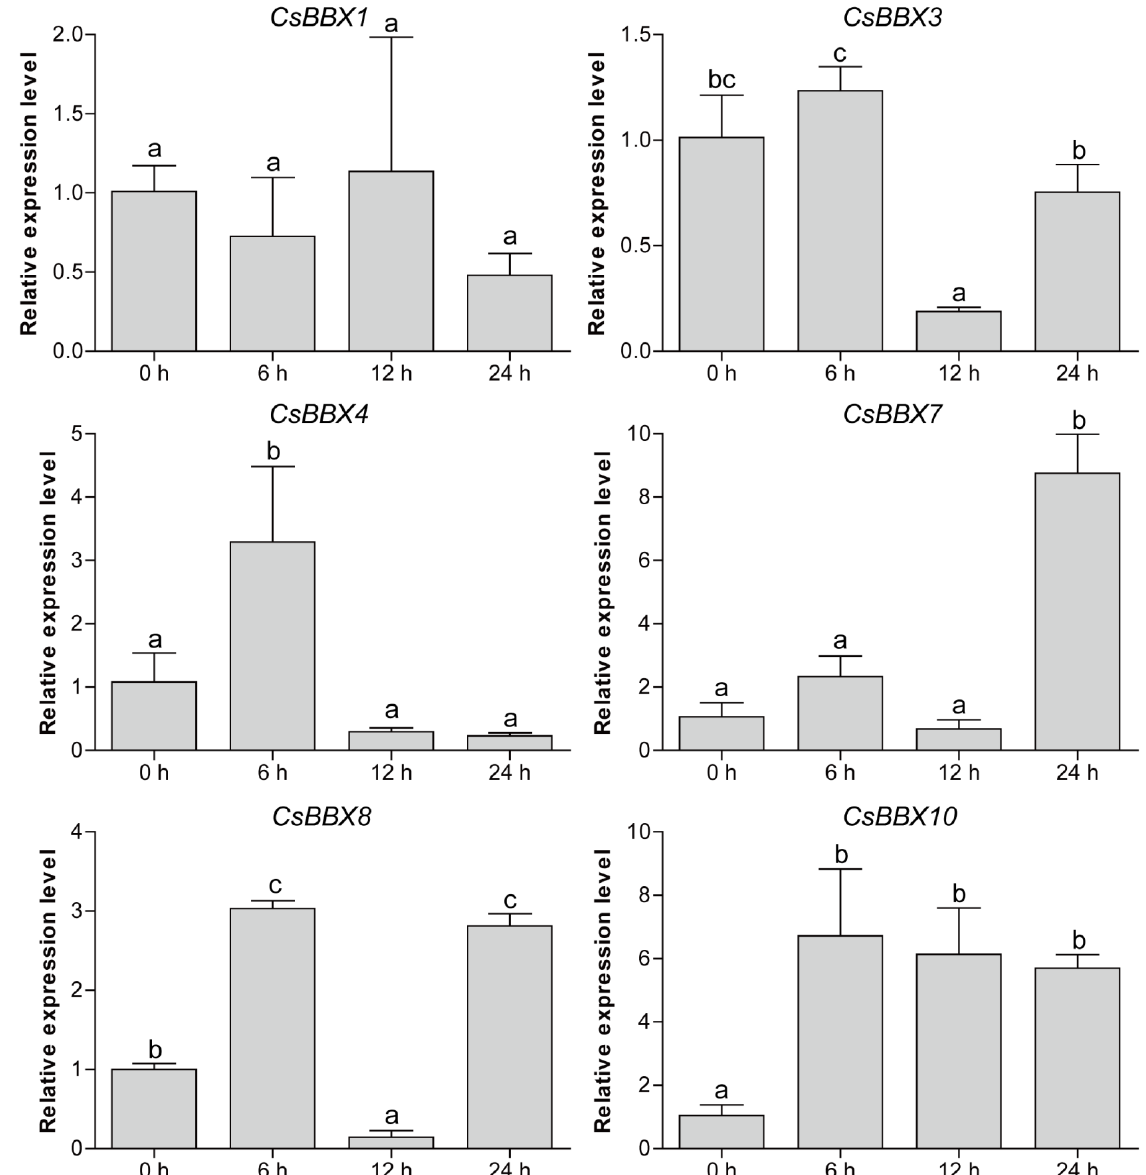
Figure 8. qRT-PCR analysis of six selected CsBBX genes under salt stress. The seedlings were treated with 200 mM NaCl for salt stress, and leaf samples were collected at 0, 6, 12, and 24 h. Data were normalized to the CsAct3 gene expression level, and the value of each CsBBX gene at 0 h was normalized as “1.0”. Different lowercase letters indicate significant differences among all the test data.